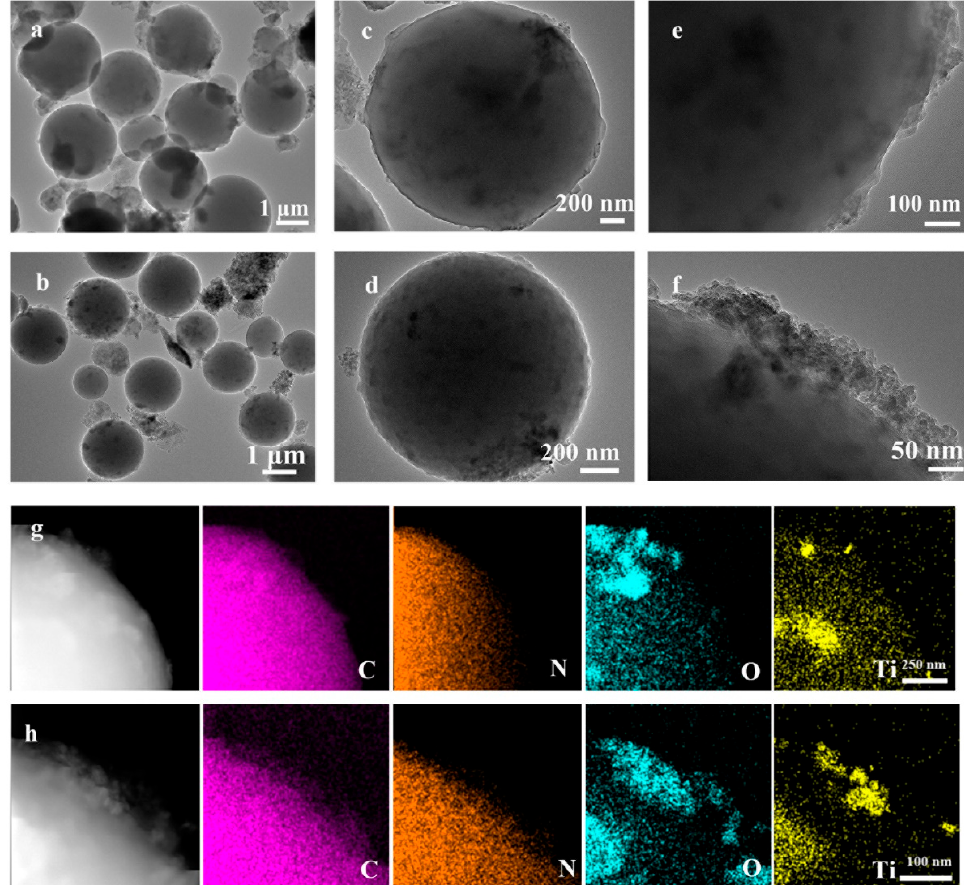
Figure 7. TEM and mapping results of pigments with different ratios of binder to nano TiO 2 . ( a , c , e , g ) 2:1; ( b , d , f , h ) 1:2.